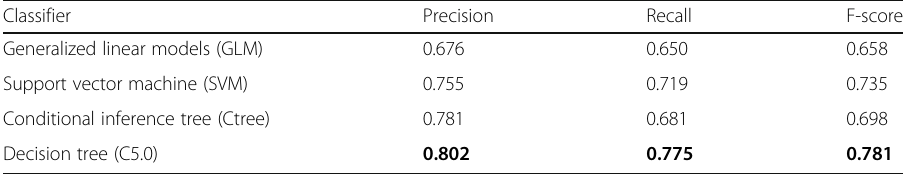
Bolded scores indicates top